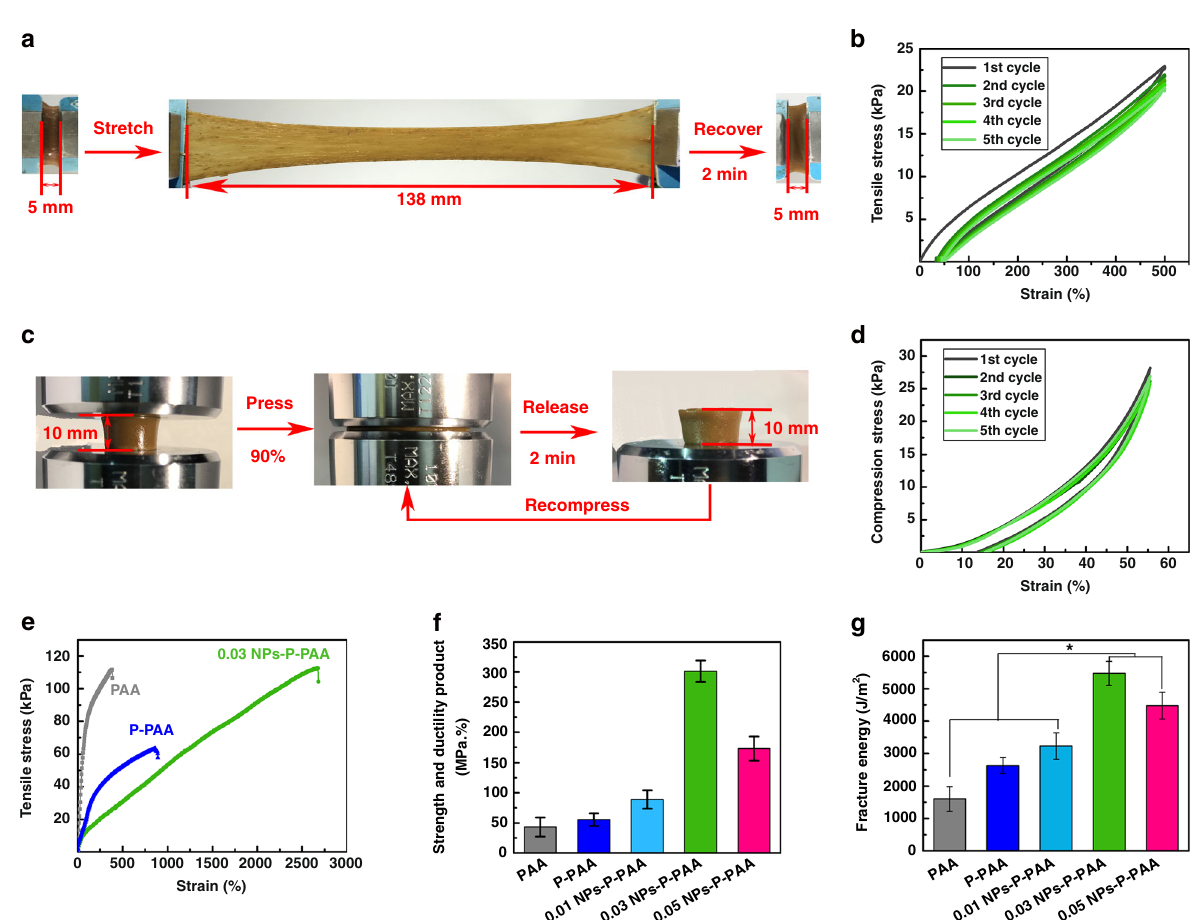
Fig. 2 Mechanical properties of the hydrogels. a The 0.03 NPs-P-PAA hydrogel was elongated to 26 times its initial length and recovered in 2min. b Tensile loading – unloading curves of 0.03 NPs-P-PAA hydrogel. c The 0.03 NPs-P-PAA hydrogel was compressed and recovered in 2min. d Compressive loading – unloading curves of 0.03 NPs-P-PAA hydrogel. e Typical tensile stress – strain curves of the hydrogel. f Strength and ductility product of various hydrogels. g Fracture energy of the hydrogels. (Error bar means the standard deviation, *indicates statistically difference at p <0.05, p value was generated